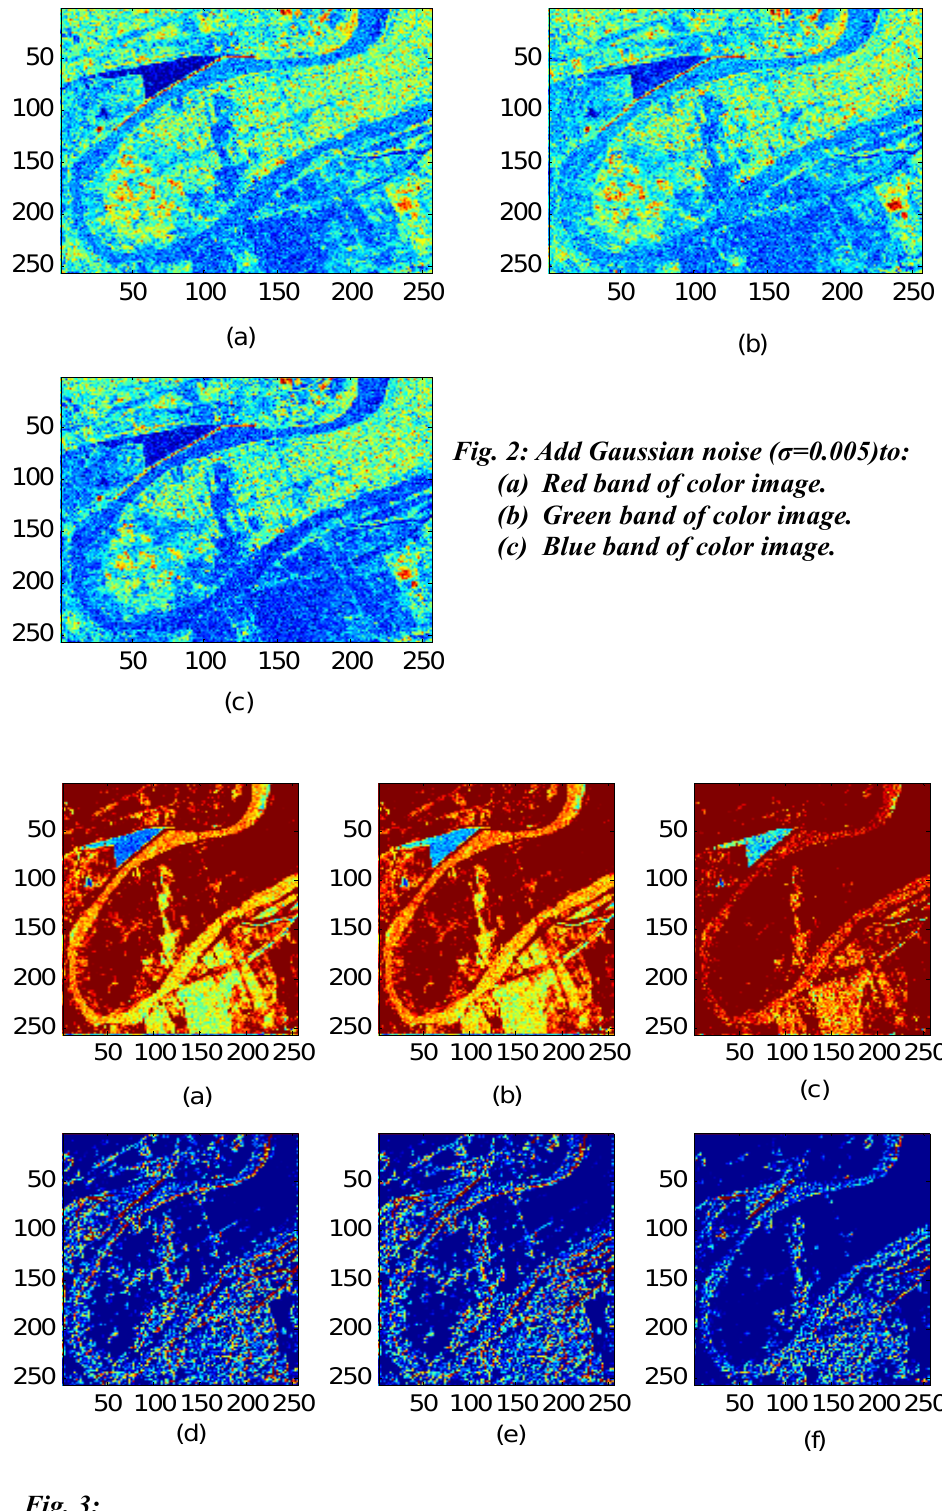
(a) Filtered noisy image by Gaussian filter. (b)Filtered noisy image by median filter. (c)Filtered noisy image by proposed filter. (d) Sobel operator in the color image filtered by Gaussian filter. (e)Sobel operator in the color image filtered by median filter. (f)Sobel operator in the color image filtered by proposed